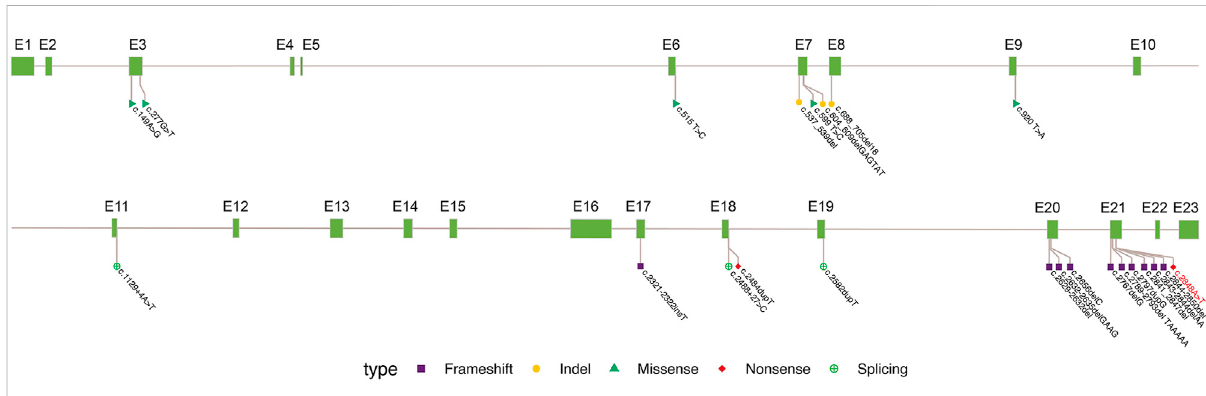
FIGURE 4 Summary of OFD1 variations in JBS10. Exon (grass – green square); variation types: frameshift (purple square), indel not causing frameshift (yellow circle), missense (green triangle), non-sense (red diamond), and synonymous (green cross circle). The site marked in red is reported in the